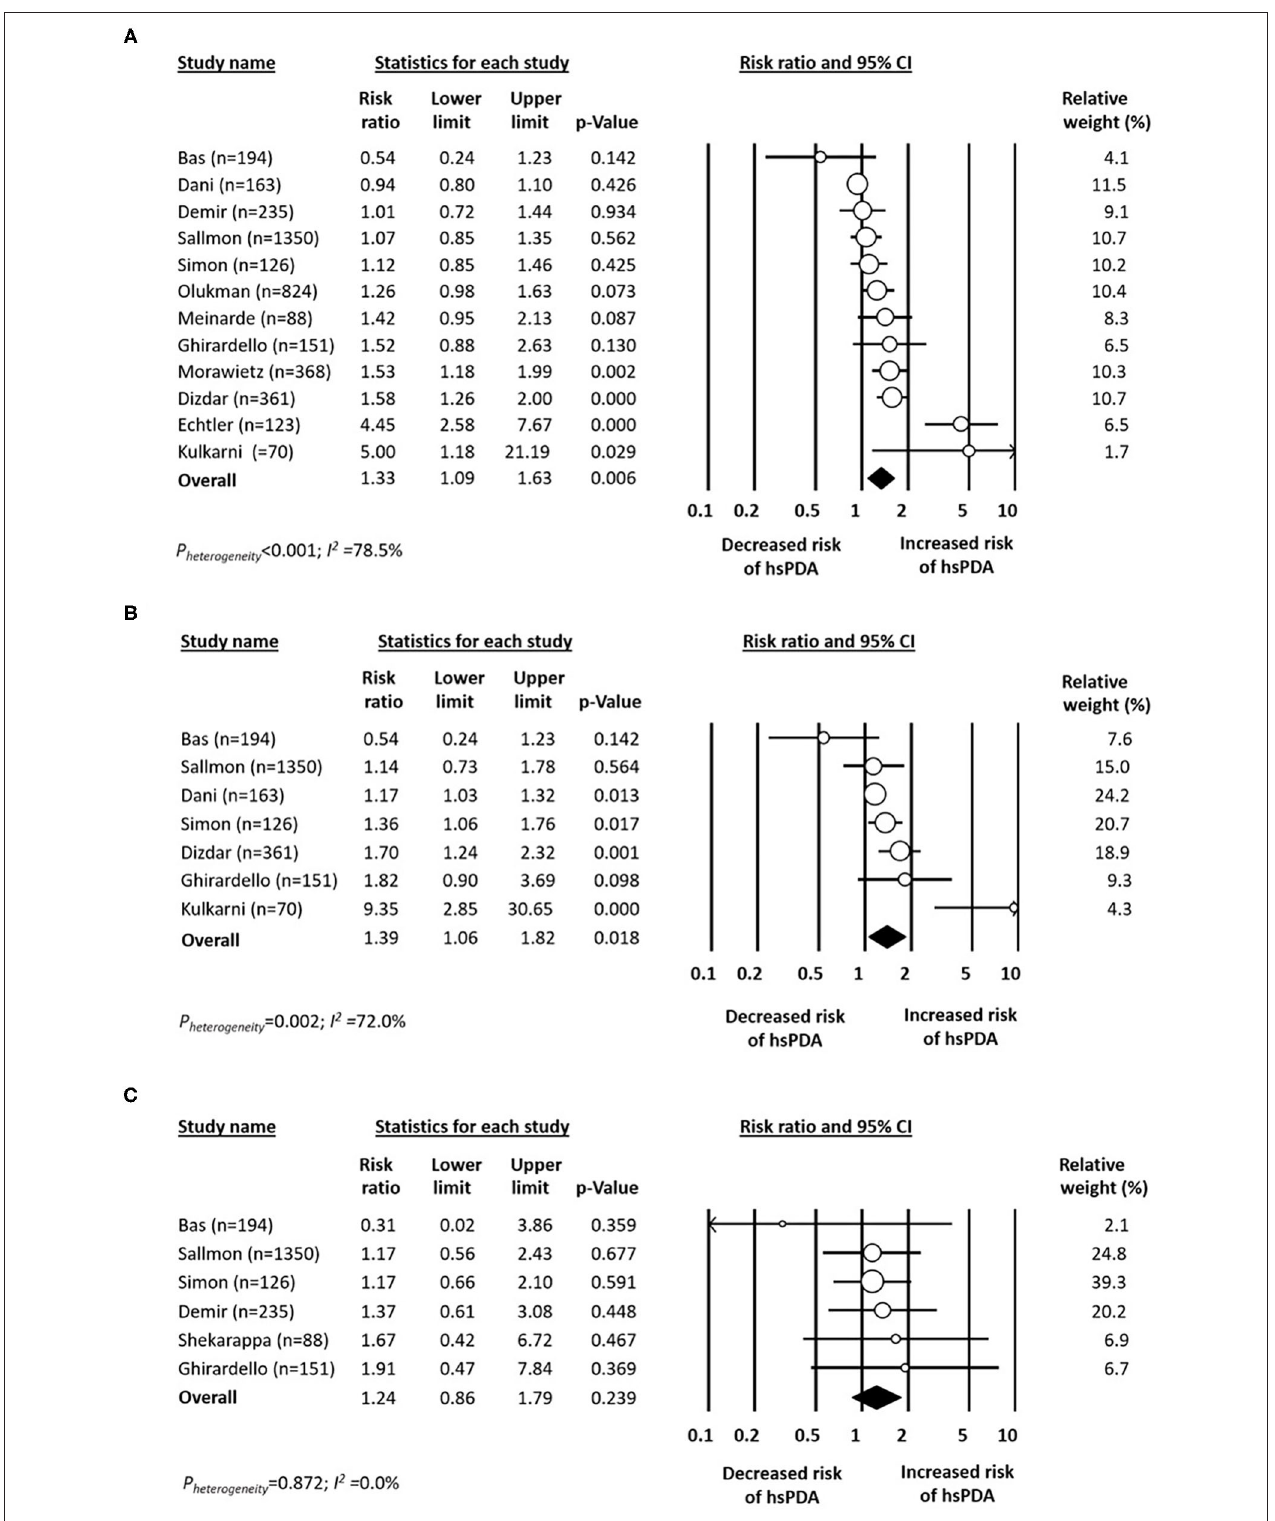
FIGURE 3 | Forest plot for studies examining the association between platelet counts (A) below 150 × 10 9 /L, (B) below 100 × 10 9 /L, and (C) below 50 × 10 9 /L in the first day(s) of life on hemodynamically significant patent ductus arteriosus (hsPDA). Risk ratio > 1 indicates increased risk of hsPDA.